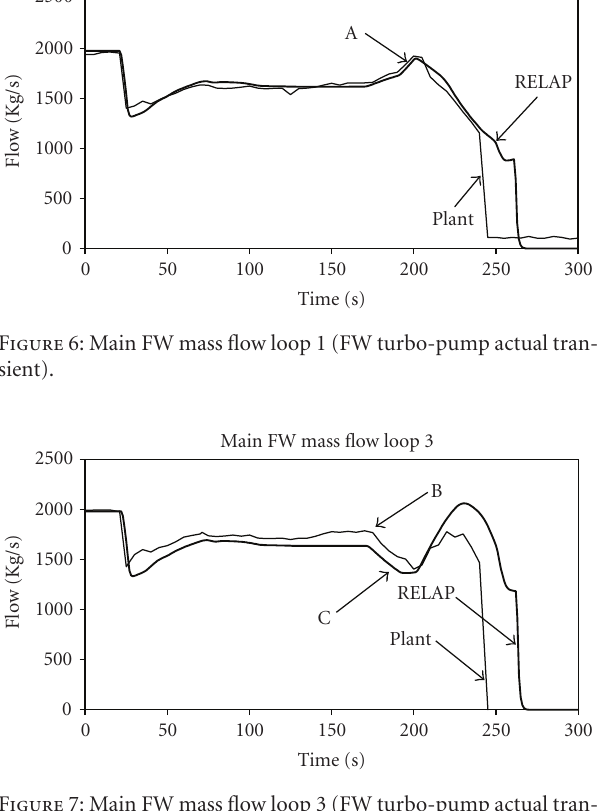
Figure 7: Main FW mass flow loop 3 (FW turbo-pump actual tran-